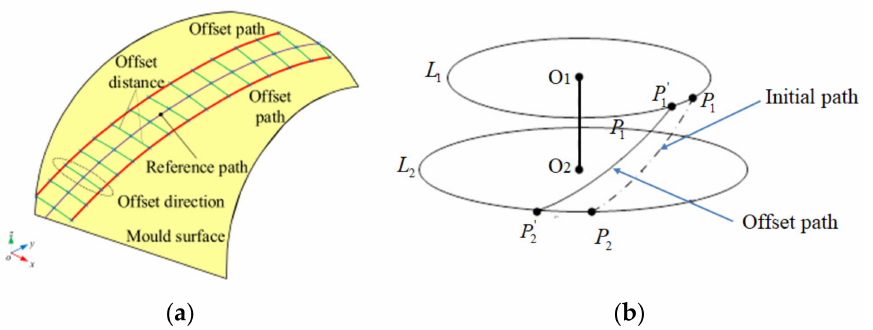
Figure 7. Concept for offsetting the initial path. ( a ) Equidistant offset [7], ( b ) Offset proportionally based on profile